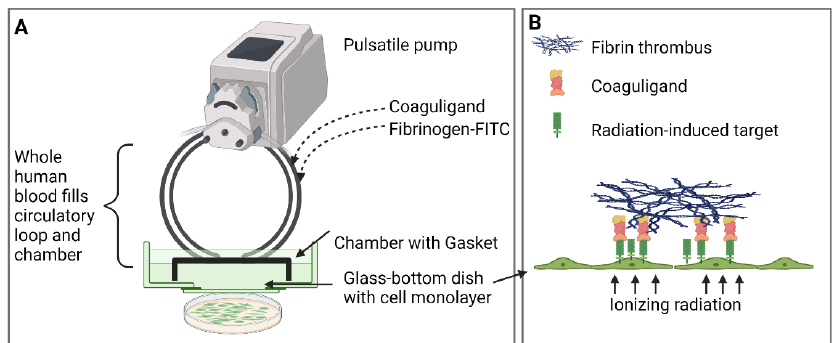
Figure 1. Schematic figure of the parallel-plate flow system. ( A ) A closed-loop pulsatile parallel-plate flow system is assembled using a chamber with a gasket that allows whole human blood or growth medium to flow dynamically over an endothelial monolayer grown on a glass-bottomed Petri dish. Cells are irradiated at set time points before construction of the system. Coaguligand or fluorescent conjugates are added to the circulation as the vascular targeting agents (VTAs). ( B ) Fibrin thrombus formation occurs over the irradiated cells after administration of fluorescently labelled fibrinogen and coaguligand to the circulation. Figure created using